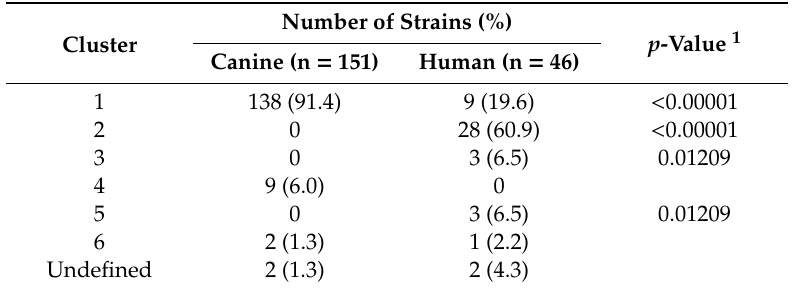
Table 5. Distribution into the phylogenetic clusters of the 197 canine and human ST372 strains.